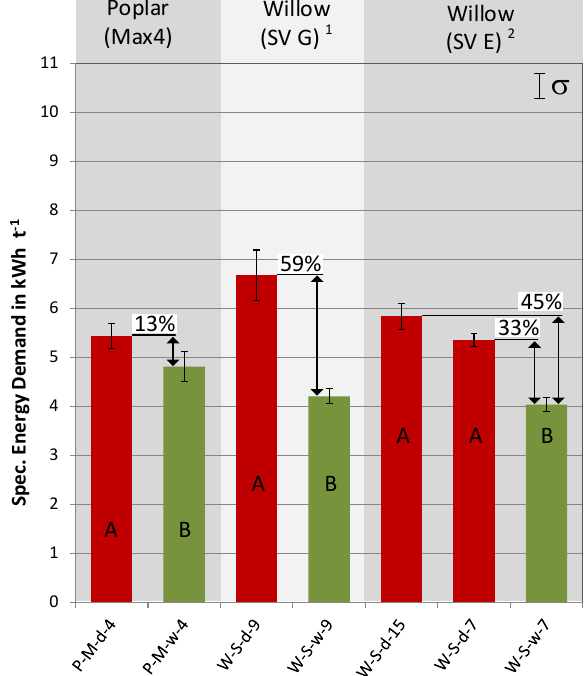
Figure 8. Comparison of the specific energy demand for chipping fresh and dried poplars and willows from SRCs (colors: green = fresh, red = dried; different letters indicate significant differences between trials ( p ≤ 0.05)). 1 Salix viminalis from ATB, Germany. 2 Salix viminalis from Rothamsted Research, England; Labelling of trials on x-axis: see Table 1.